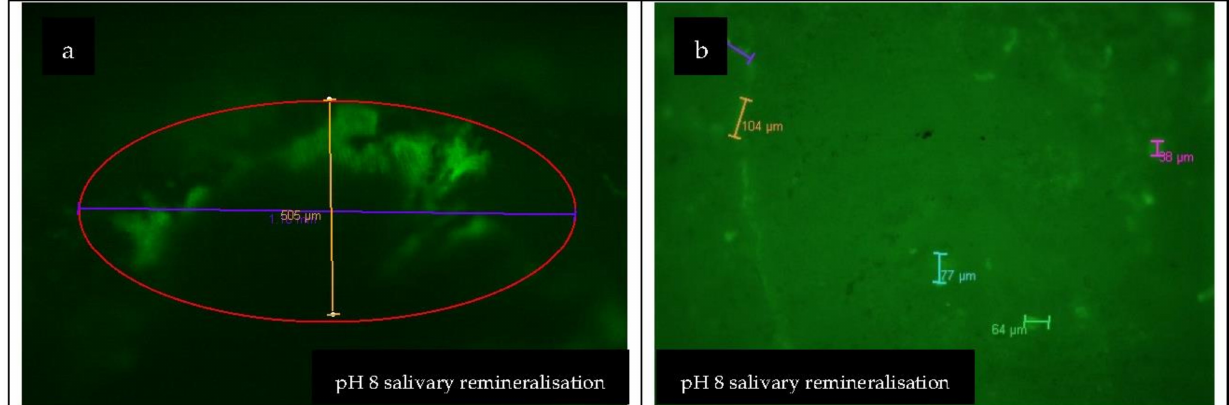
Figure 9. CLSM images of: ( a ) pH 8 salivary remineralisation; ( b ) pH 8 salivary remineralisation, magnified view.